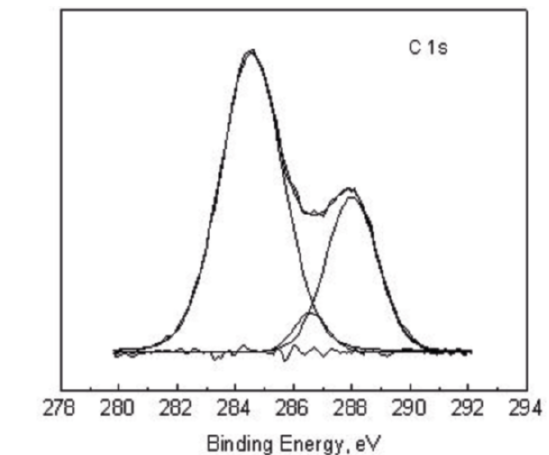
Figure 6. C1s XPS spectrum of sample “Precursor”.